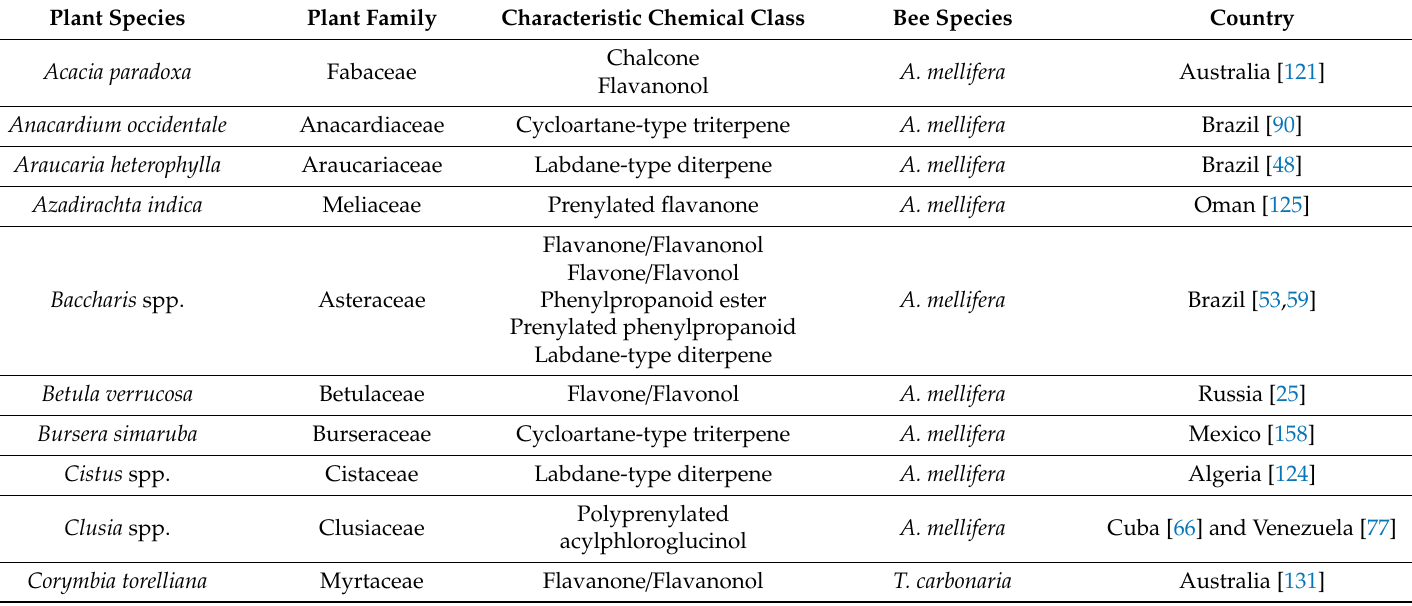
Figure 8. Characteristic chemical constituents of propolis (black: compound name; blue: compound class; purple: continental distribution). ( A ) HBP; ( B ) SBP. Table 1. Botanical sources of propolis categorized by chemical class.